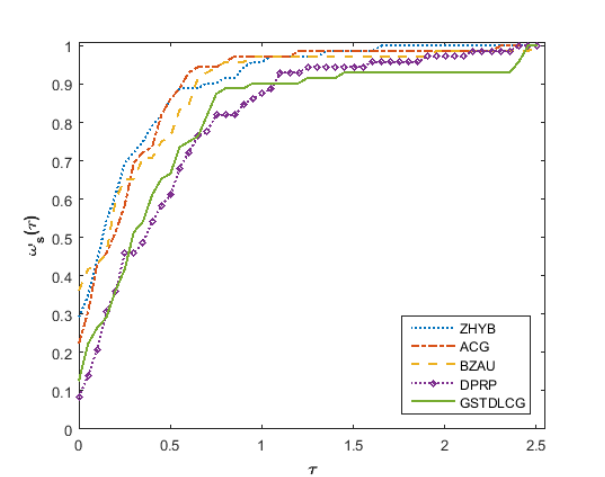
Figure 2: Number of function evaluations performance